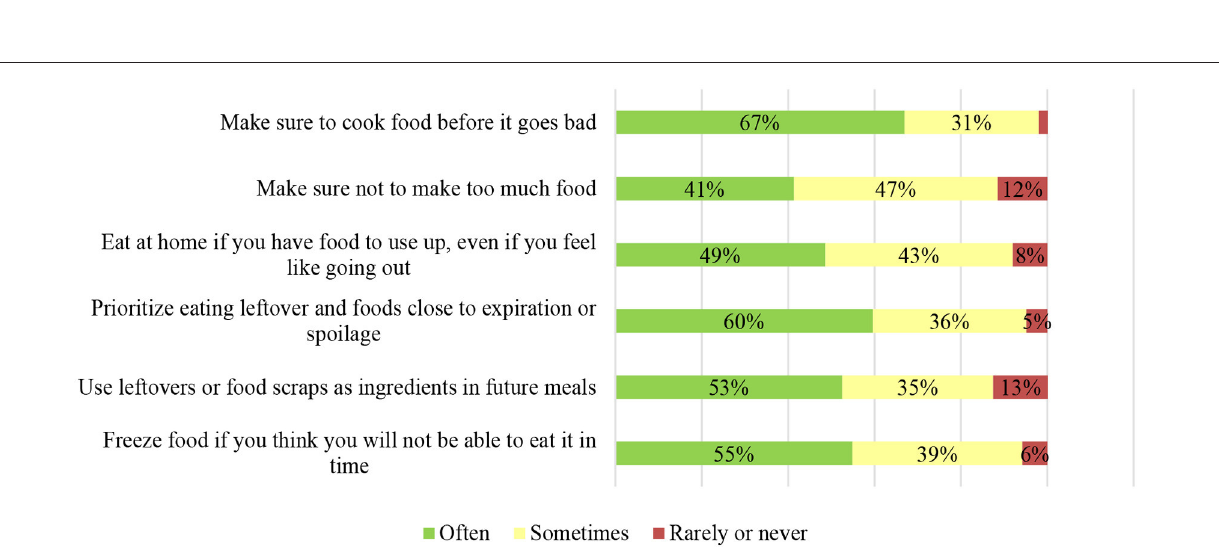
place-based solutions are needed to further reduce food